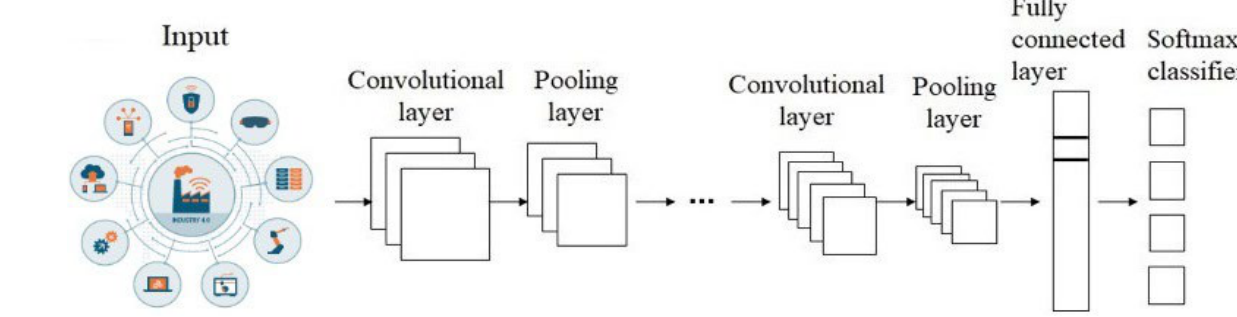
Figure 4. Structure of the CNN model based on ICS attack detection.